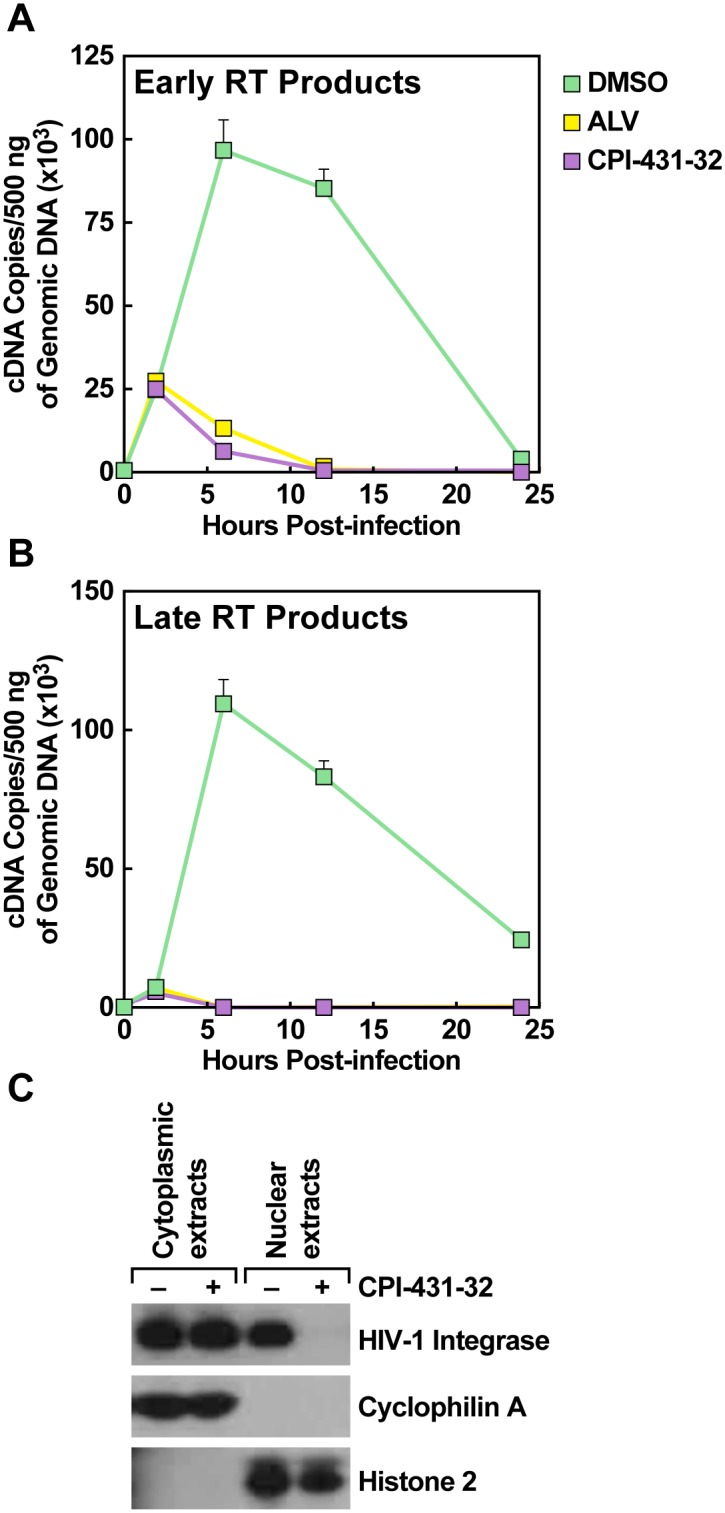
CPI-431-32 blocks HIV-1 reverse transcription and nuclear import.TZM cells were infected with DNase-treated NL4-3 HIV-1 together with DMSO or CPI-431-32 (2 μM). Target cell DNA was isolated at the indicated times and was used to detect early (A) and late HIV-1 reverse transcripts (B). TZM cells were infected with NL4.3 in the presence or absence of CPI-431-32 (2 μM). Six hours post-infection, cells were fractionated and cytoplasmic and nuclear extracts analyzed by Western blotting (C). Results are representative of two independent experiments.